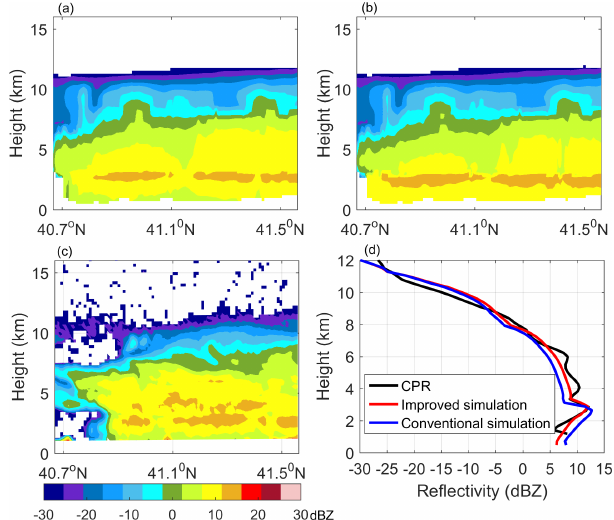
Figure 10. Radar reflectivity comparison between the simulation results and CloudSat CPR observation data for the stratiform cloud precipitation case. (a) Cross section of the simulation result with the improved setting, (b) cross section of the simulation result with the conventional setting, and (c) cross section of the CloudSat CPR observation data. (d) Vertical profiles of the average reflectivity in (a) – (c) , where the red line represents the simulation result with the improved setting, the blue line represents the simulation results with the conventional setting, and the black line represents the results of the CPR observation. Owing to the melting modeling in the im- proved simulation, the echo structure and intensity were consistent with the CPR observation